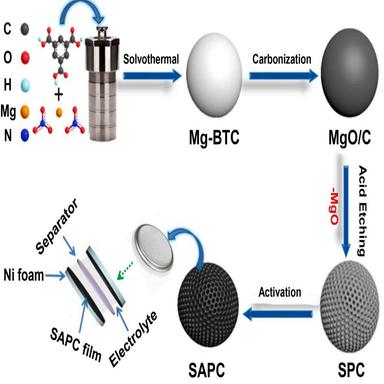
Schematic illustration of the preparation of SAPC derived from Mg-BTC.